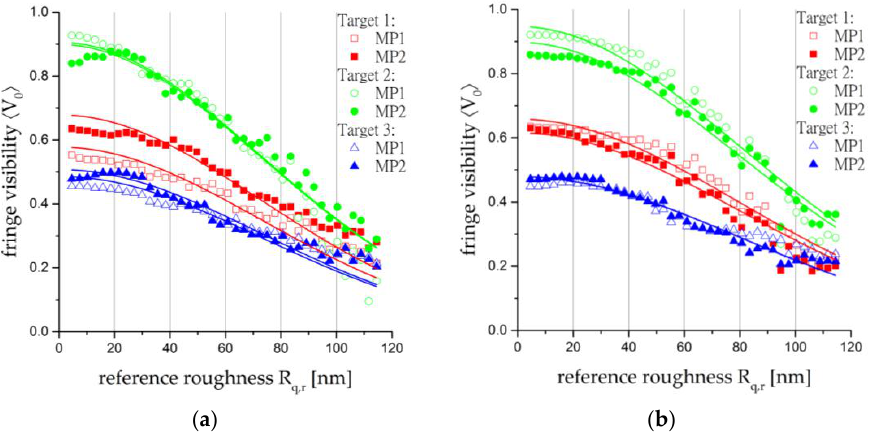
Figure 9. Experimental results and fit curves for the laser lines ( a ) 501.7 nm. 